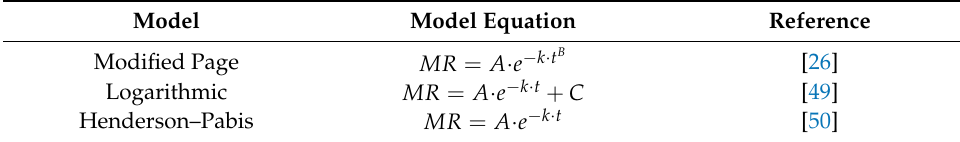
Table 5. Models used to describe drying